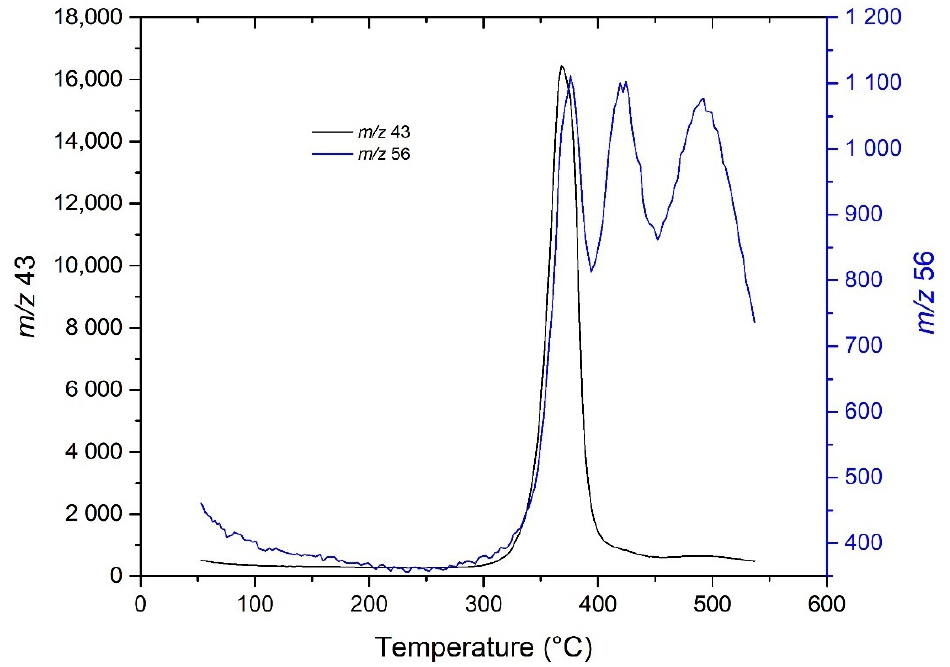
Figure 9. Peaks at m / z 56 obtained with the capillary heated to 280 °C. The peak of the signal at m / z 43 from the same experiment is also shown for comparison (n.b., the two peaks have different y- axes).